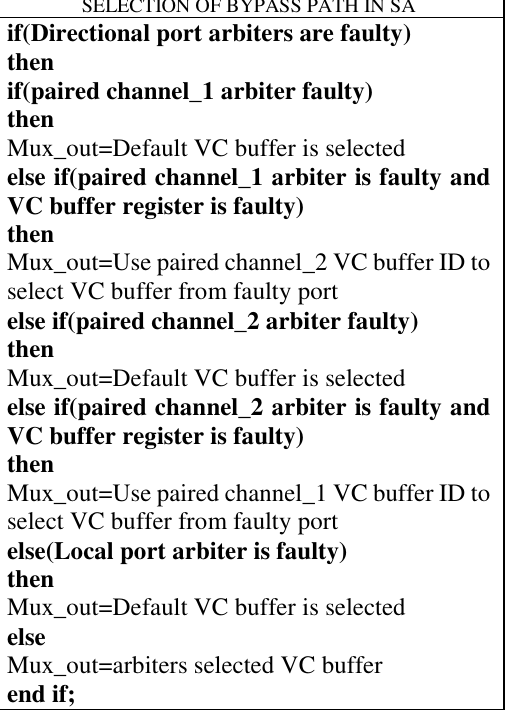
ALGORITHM-2: PSEUDO CODE FOR THE SELECTION OF BYPASS PATH IN SA if(Directional port arbiters are faulty)